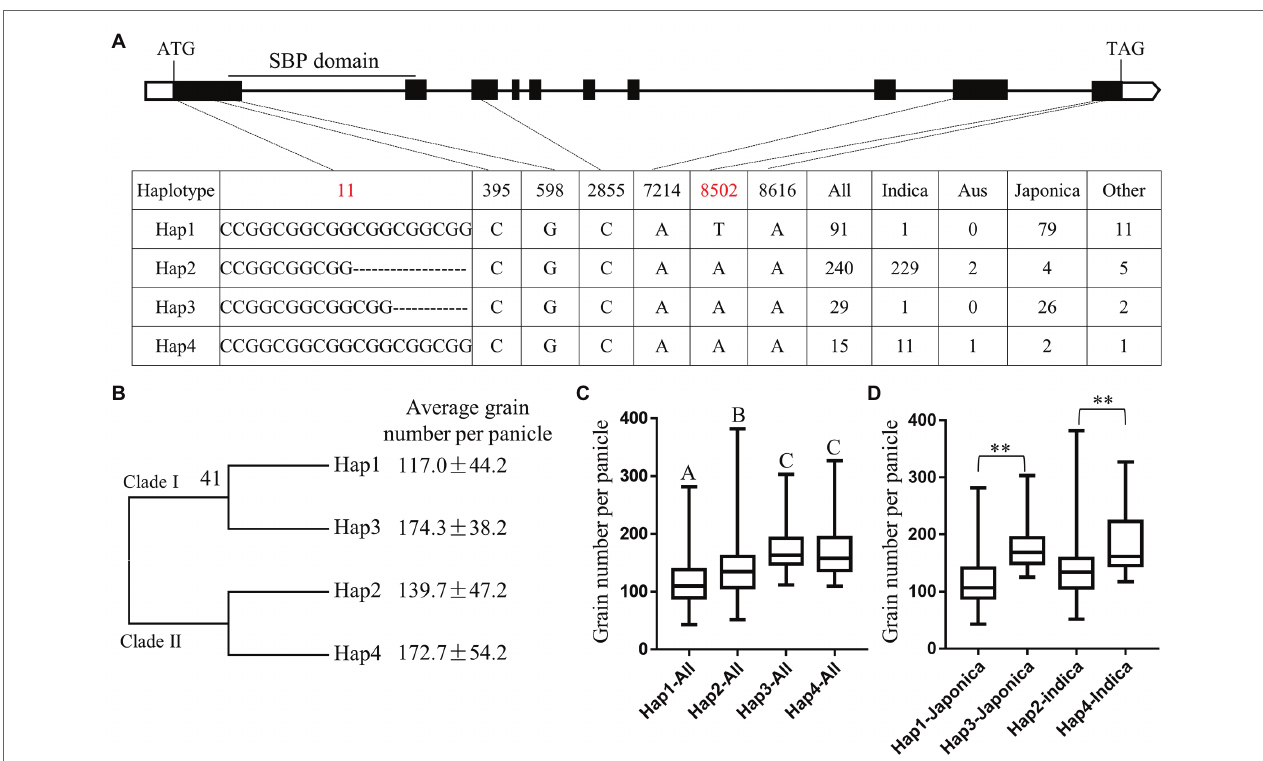
FIGURE 5 | Haplotype analysis of OsSPL9 in rice accessions. (A) Single nucleotide polymorphism (SNP) divergence in the coding region of OsSPL9 . (B) Phylogenetic analysis of OsSPL9 coding region using the neighbor-joining method. (C) The average GNP of OsSPL9 haplotypes in cultivars. Data are means ± SD. n = 91, 240, 29, and 15. The letters above the error bars indicate significant differences at p < 0.01 using multiple comparisons. (D) Comparison of the average GNP of OsSPL9 haplotypes in the same subspecies. Data indicate means ± SD. n = 79, 26, 229, and 11. Significant differences are determined using Student’s t -test. ** indicates p <